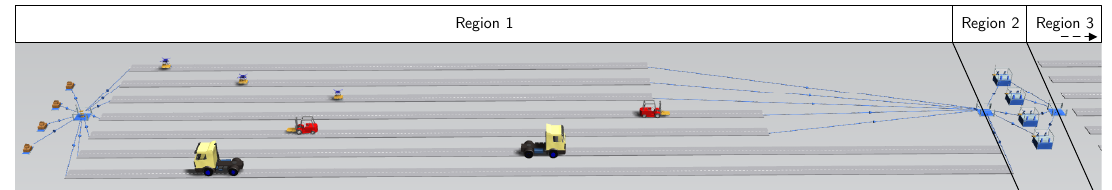
Figure 8. A graphical representation of the simulation model. A product flows from region 1 to region 2 after which it undergoes processing. After a product is processed, a transporter moves the cargo from region 2 to region 3. For representation purposes, region 3 is left out of this illustration, but this region is comparable to region 1 (see [20] for more graphical representations).